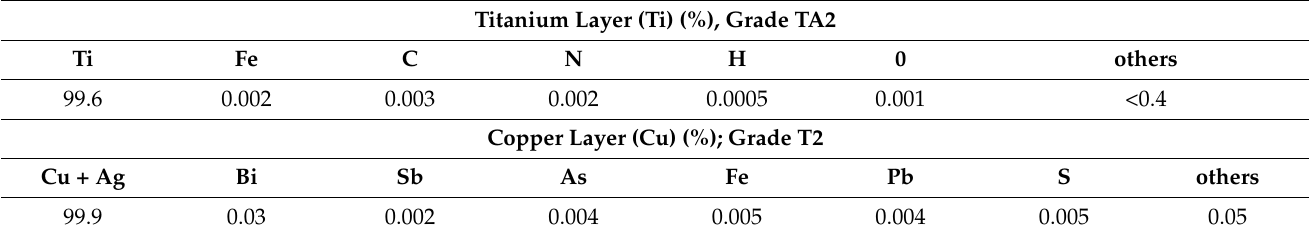
Table 1. Chemical composition of the titanium (Ti) and copper (Cu) layers [28].